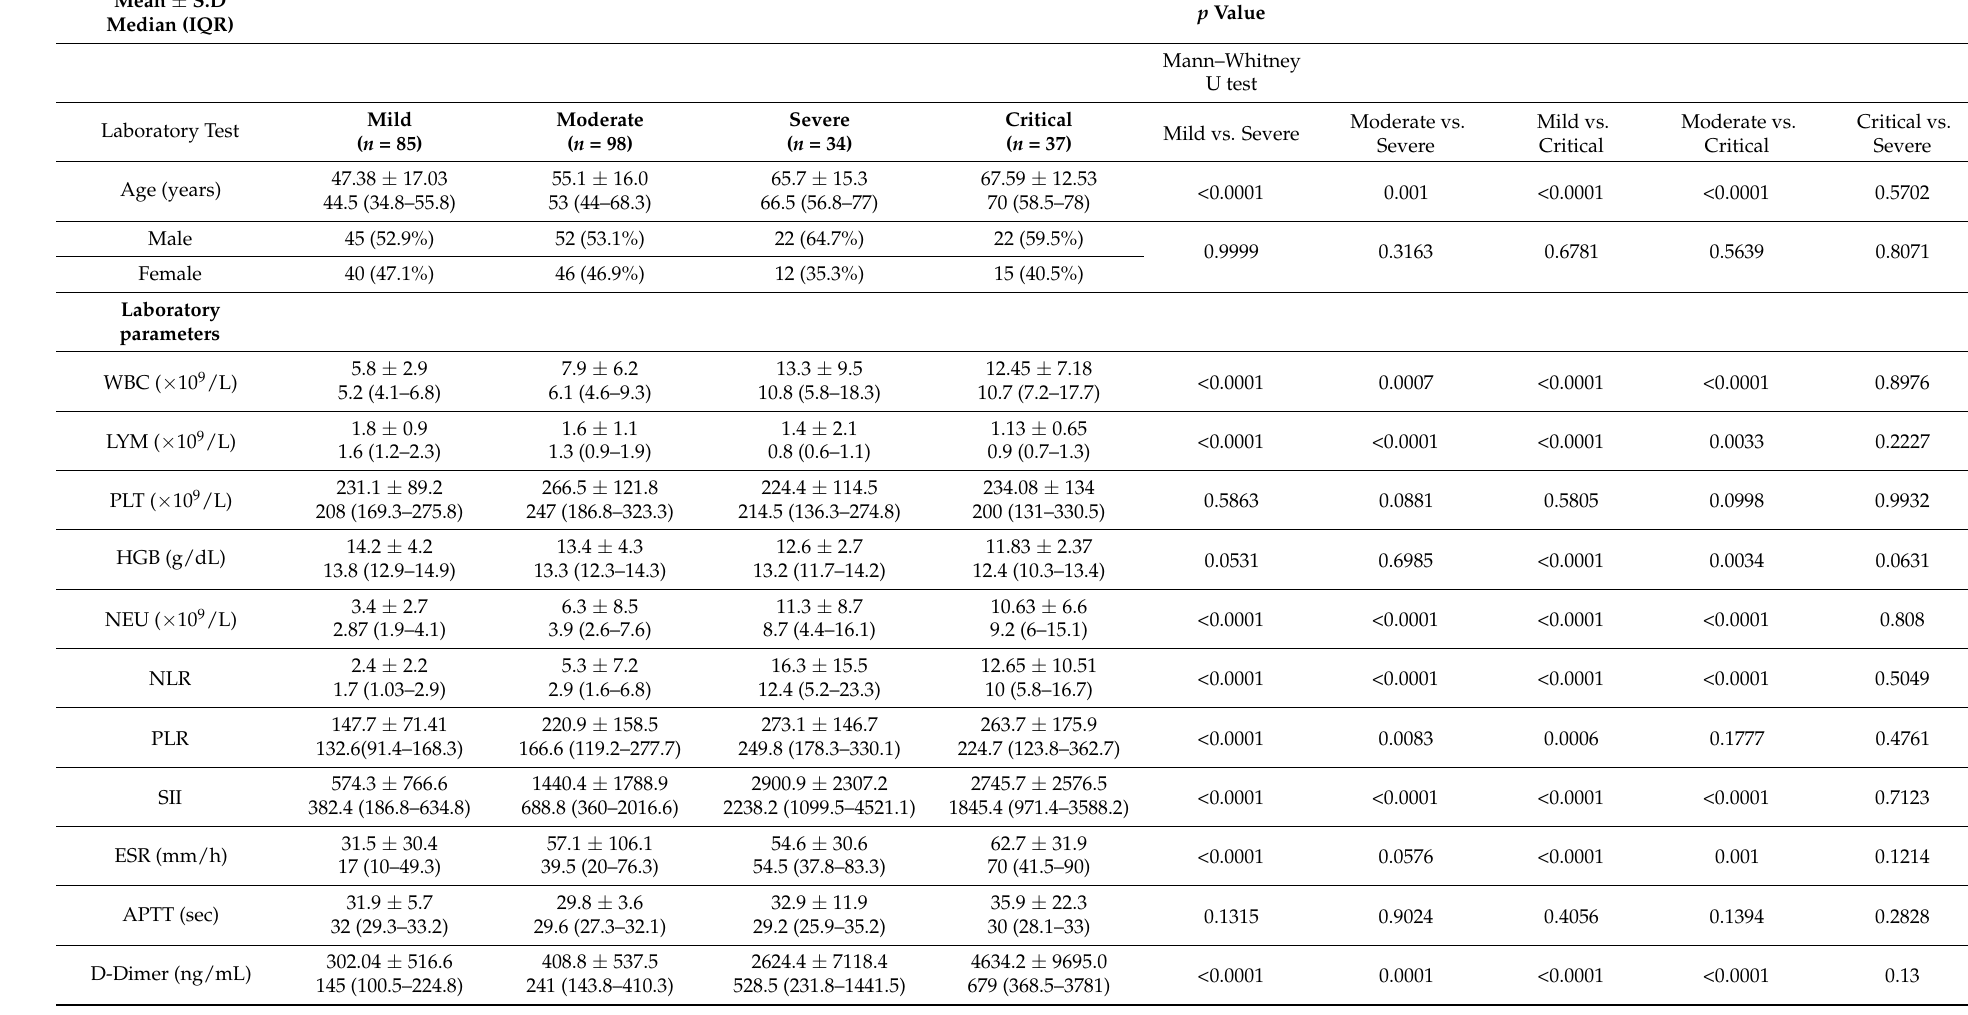
Table 2. Differences between levels of laboratory variables at admission and clinical severity (Mild, Moderate, Severe, Critical). Mean ±